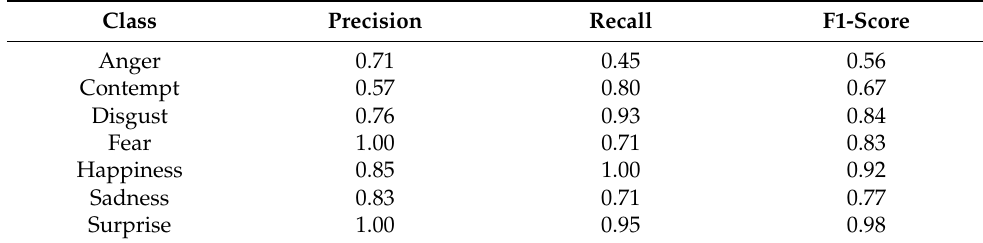
Table 12. SVM training results for iteration 2 of K-fold stratified using dataset2